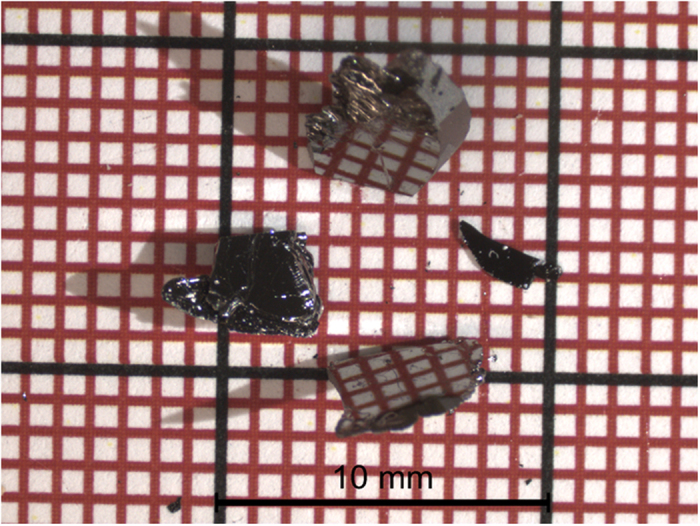
FeAs-grown single crystals of Ba1-xTlxFe2As2.